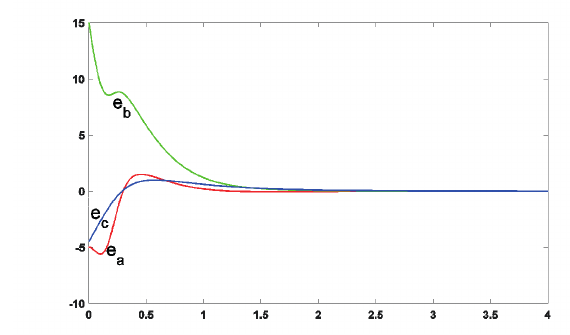
Fig. 4: The errors of the drive system parameters estimations.